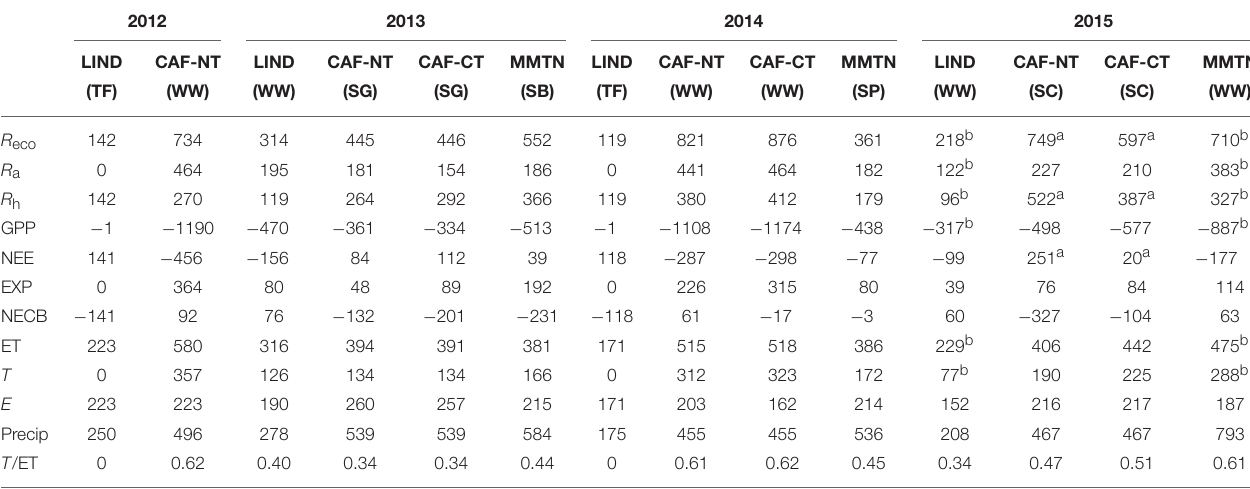
TABLE 5 | CropSyst annual carbon (g C m − 2 ) and water (mm) budgets for 14